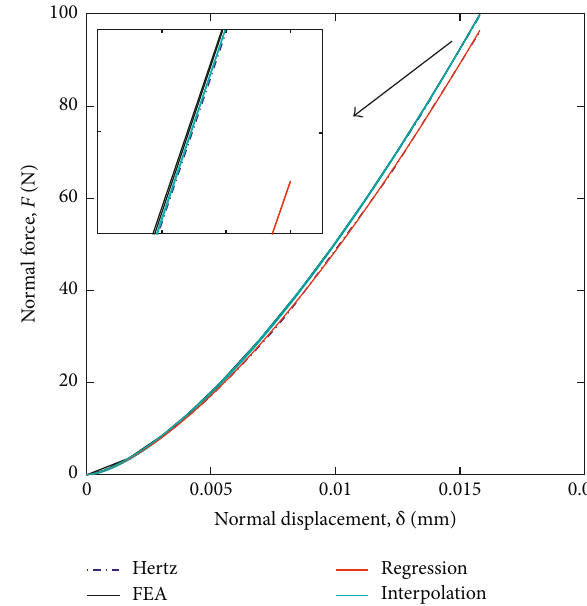
Figure 11: Normal force versus normal displacement for elastic- plastic deformation (type 1 in Table 3).